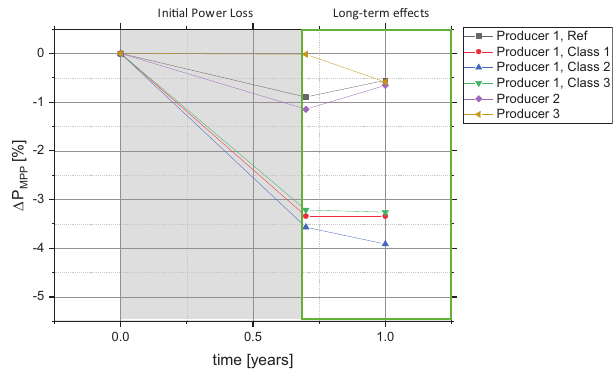
Fig. 11. PMPP changes derived from Interim IV-curves at STC of LECO modules.